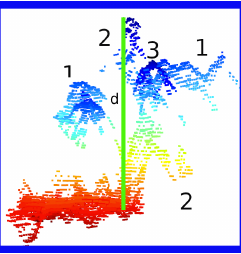
Figure 10. Seedling Features. The red portion corresponds to the agrolite. The number one is the cotyledons, number two is the first true leaf, and number three is the second true leaf. The green line represents the normalized height of the seedling.